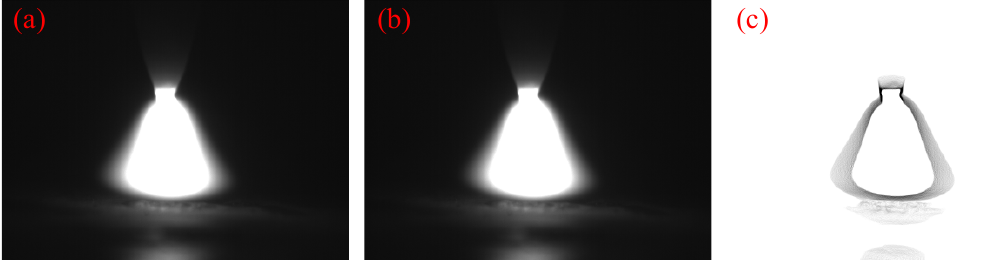
Figure 4. Arc image processing process. ( a ) original image, ( b ) threshold processing image, and ( c ) extracted image.